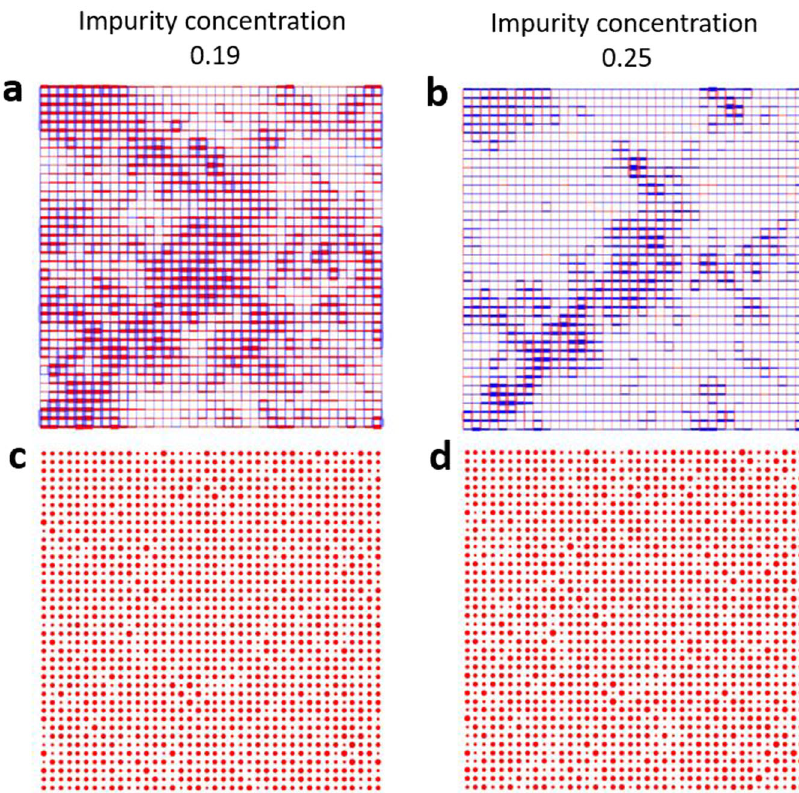
Fig. 3 The real-space distribution of the pair fi eld. The upper two panels are for d -wave pairing (where the pair fi elds lie on nearest-neighbor bonds); the lower two panels are for s -wave pairing (where the pair fi elds are on-site). The size of the symbols, namely the thickness of the bonds in ( a ) and ( b ), and the size of the dots in ( c ) and ( d ), represents the magnitude of the pair fi eld whereas the color (red positive, blue negative) the sign. The left and right columns correspond to two different impurity concentrations. The magnitude of pair fi eld in panel a ranges from 0.0003 to 0.103 while that in ( b ) ranges from 0.000005 to 0.1008. In c and d , the magnitude of the pair fi eld on each site ranges from 0.076 to 0.18 and 0.073 to 0.20, respectively.